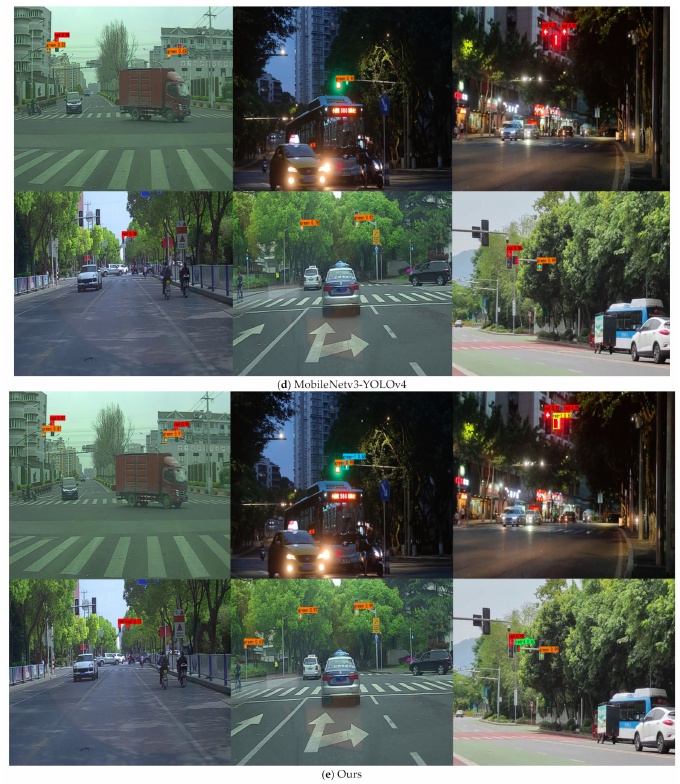
Figure 11. The predicted confidence results of different